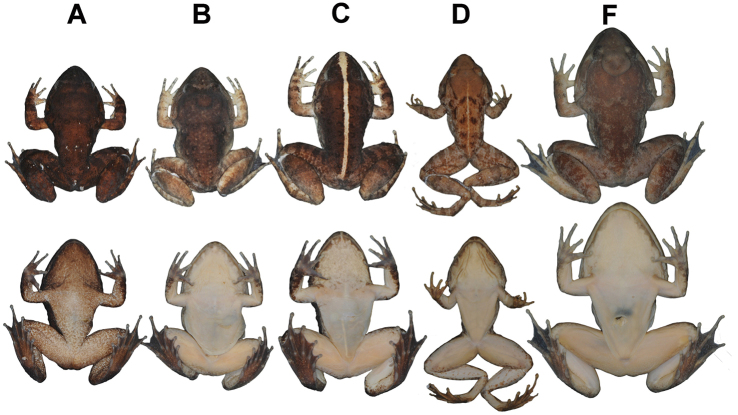
Comparisons of males of four similar, caruncle-bearing species of Limnonectes in preservative: Dorsal (above) and ventral (below) views of AL.savan sp. nov. holotype male (NCSM 76288) BL.dabanus (MVZ 258200) with high-profiled caruncle from Ratanakiri Province, Cambodia CL.dabanus (MVZ 258202) with low-profiled caruncle from Ratanakiri Province, Cambodia DL.macrognathus (FMNH 174526) from Nakhon Si Thammarat Province, Thailand EL.gyldenstolpei topotype (ZMKU AM 01143) from Lampang Province, Thailand.